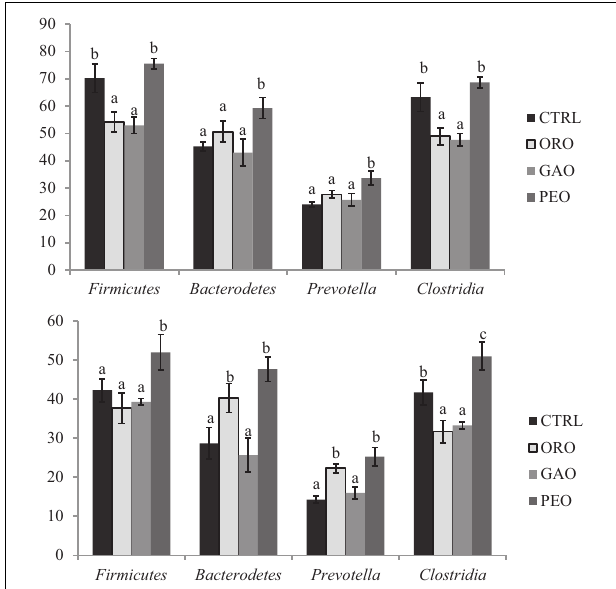
FIGURE 1 | Average number of major bacterial OTUs (relative abundance of ≥ 0.5 or ≥ 1%) identified in Firmicutes, Bacteroidetes, Clostridia, and Prevotella . CTRL, control; ORO, origanum oil; GAO, garlic oil; PEO, peppermint oil; Different letters (a–c) above the bars indicate significant ( P ≤ 0 .05) differences among the treatments (three replicates per